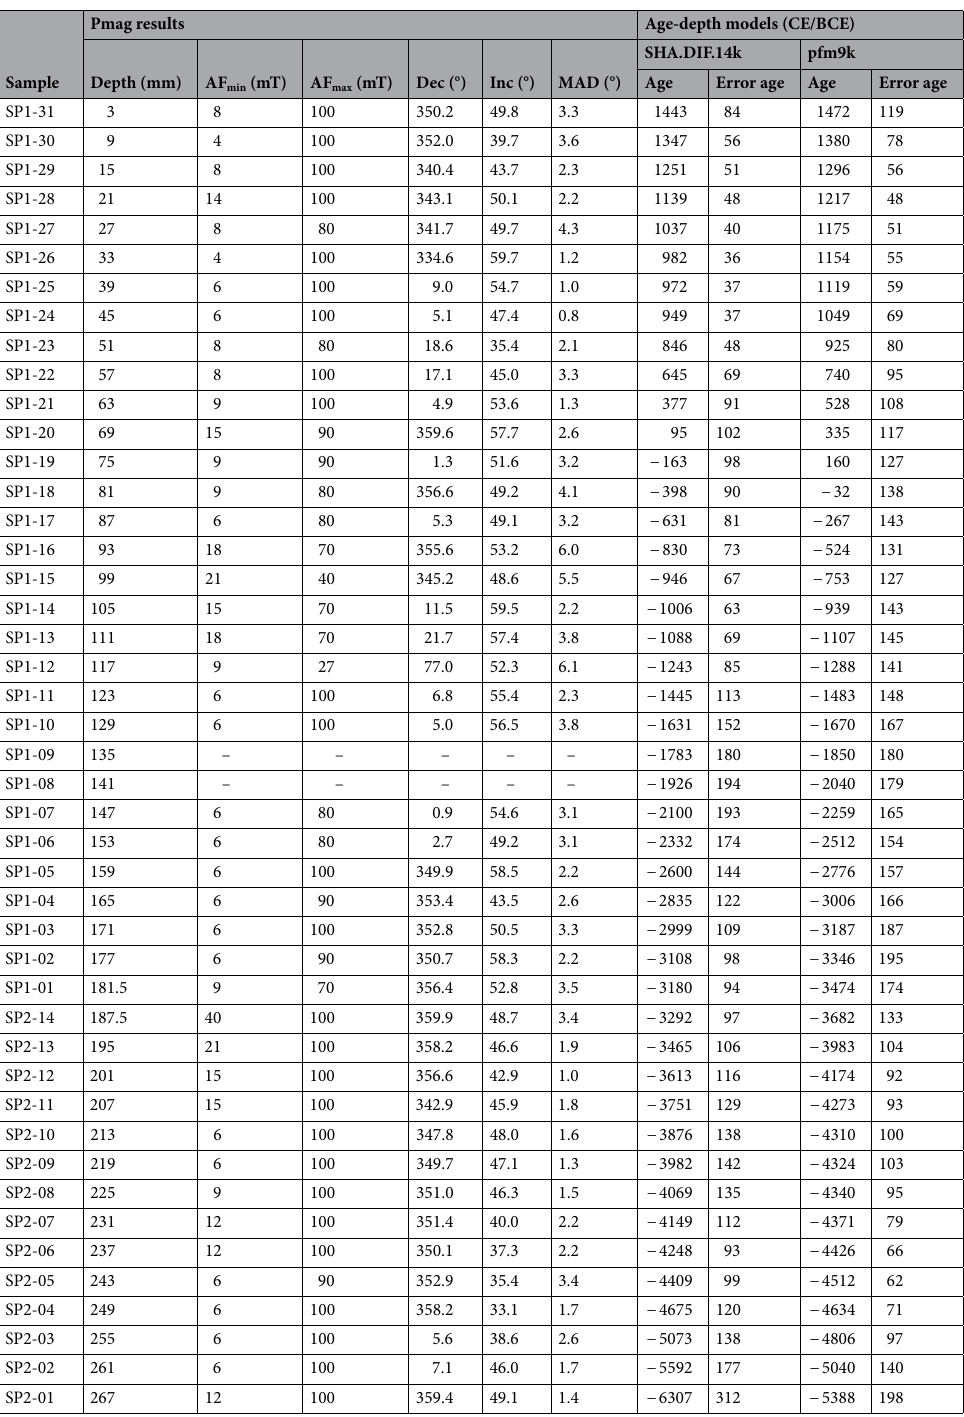
Table 2. Paleomagnetic data and age model results for Soprador do Carvalho speleothem (each paleomagnetic direction corresponds to n = 1). Error ages are given at 95% of probability. Sample name of the measured specimen, Depth depth of the central point of each sample, AF min − AF max minimum and maximum alternating field steps selected to calculate paleomagnetic direction (i.e. ChRM, characteristic remanent